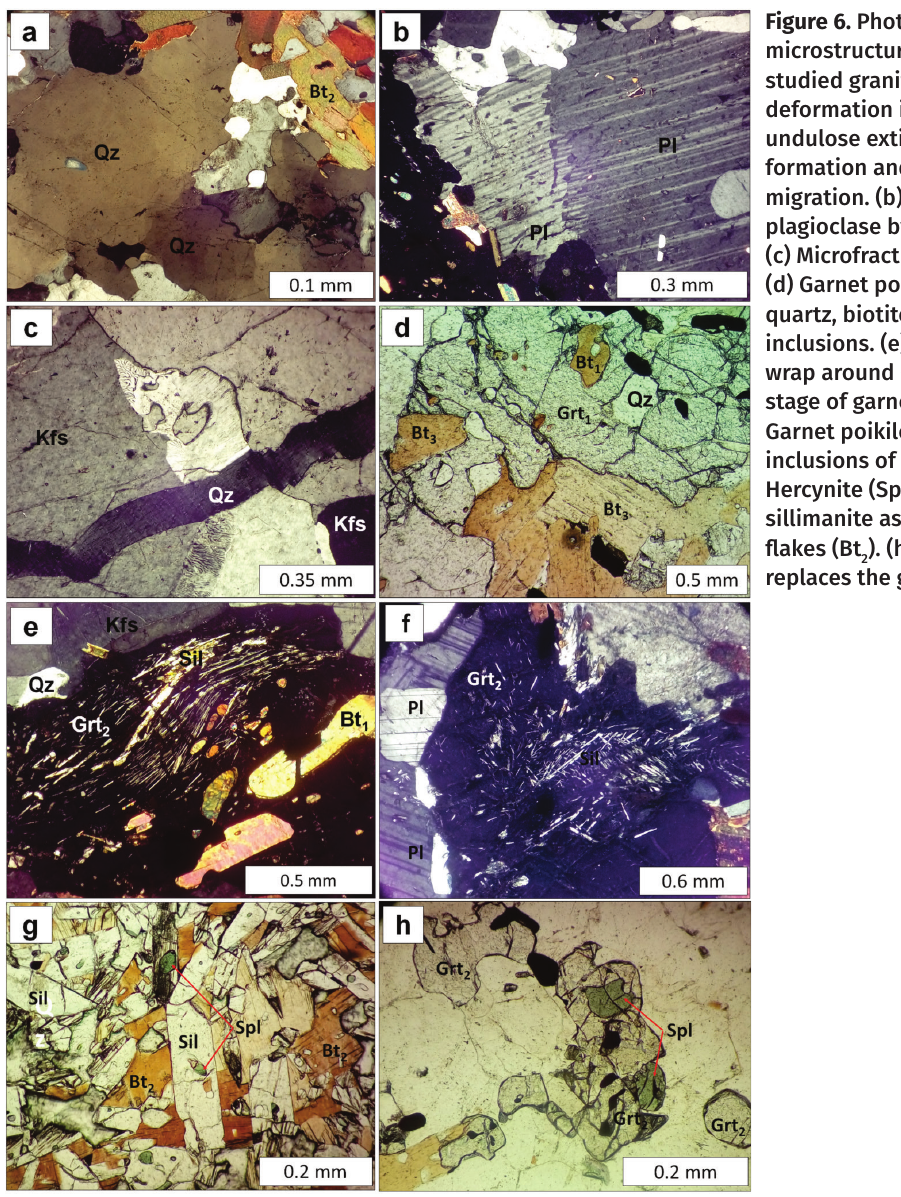
Figure 6. Photomicrographs of microstructures observed in the studied granites. (a) Evidence of deformation in quartz grains include undulose extinction, subgrain formation and grain boundary migration. (b) Recrystallized plagioclase by subgrain rotation. (c) Microfracture filled by quartz. ) host (d) Garnet poikiloblastic (Grt 1 quartz, biotite (Bt ) and ilmenite 1 inclusions. (e) Sillimanite needles wrap around Grt , forming a second 1 stage of garnet growth (Grt ). (f) 2 ) showing Garnet poikiloblastic (Grt 2 inclusions of sillimanite needles. (g) Hercynite (Spl) inclusions in prismatic sillimanite associated with biotite ). (h) Hercynite partially flakes (Bt 2 replaces the garnet